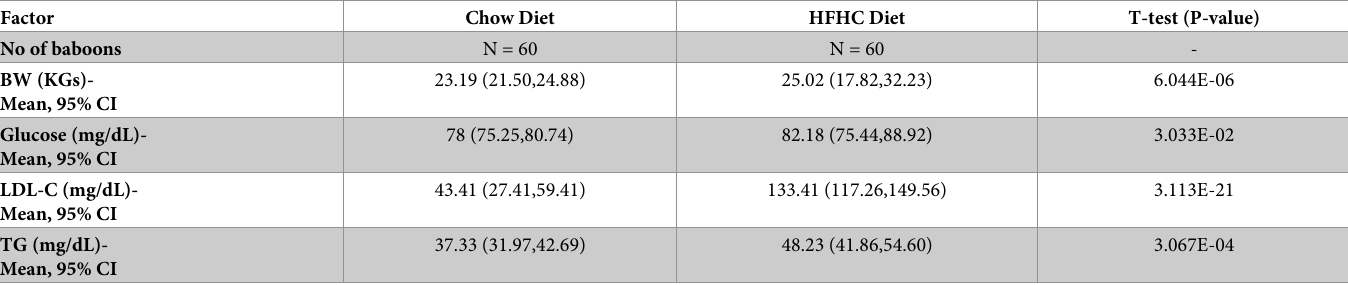
Table 1. Comparisons of changes from baseline (0yr, Chow diet) to treatment (2 yrs, HFHC diet) in clinical measures between the two treatments (diet)